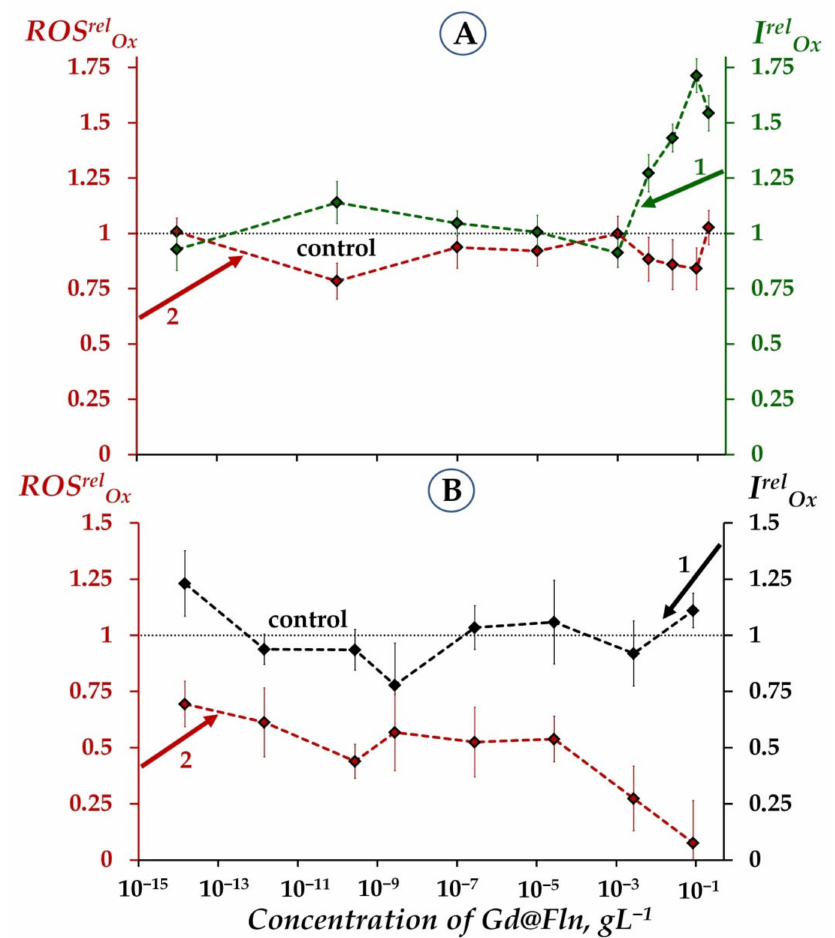
Figure 3. Antioxidant coefficients, I rel Ox , (1) and relative ROS content, ROS rel , (2) in bacterial sus- pension ( A ) and enzymatic system ( B ) vs. concentration of fullerenol Gd@Fln. Time of exposure to Gd@Fln was 45 min. Concentrations of ROS in the control bacterial suspension (bacteria + 1,4- benzoquinone at EC 50 = 8 · 10 − 7 M) and control enzymatic system (enzymes + 1,4-benzoquinone at EC 50 = 10 − 5 M) were 5.8 · 10 − 6 M and 4.9 · 10 − 5 M, respectively. “Control” corresponds to the absence of Gd@Fln in the experimental